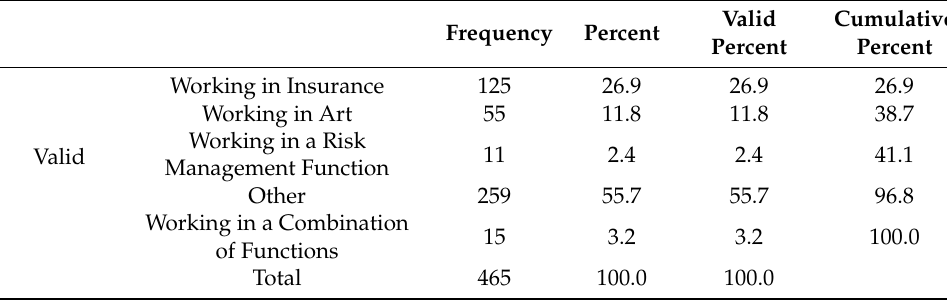
Table 3. Occupation/field of study.